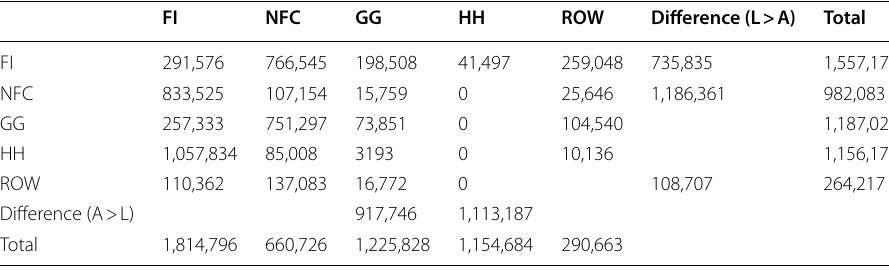
Table 14 CNY-based FFS for China (in units of 100 million